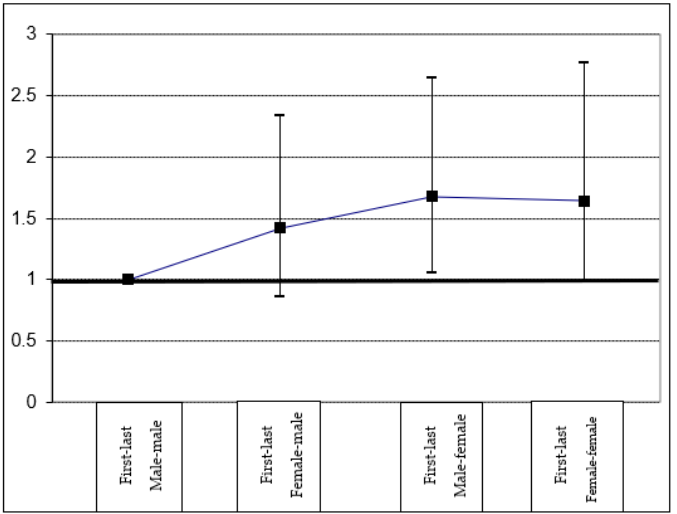
Figure 3. Odd ratios (95% confidence interval) of sex-disaggregation of results according to the combination of the sex of first and last authors.